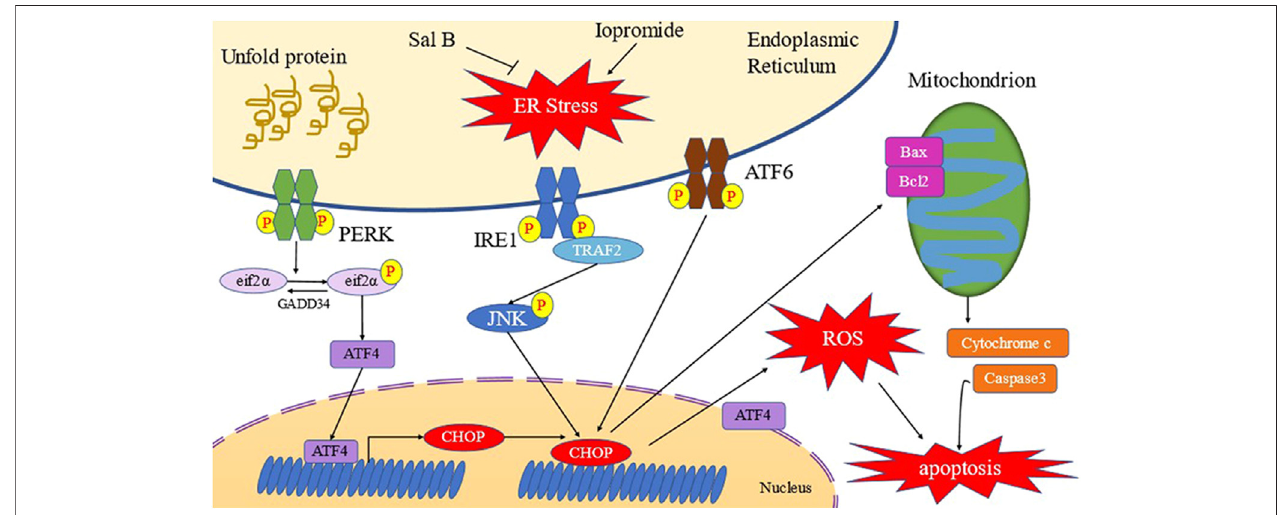
FIGURE 10 | Schematic diagram of Sal B inhibiting ERS of HK-2 cells induced by iopromide (Yang et al., 2020).